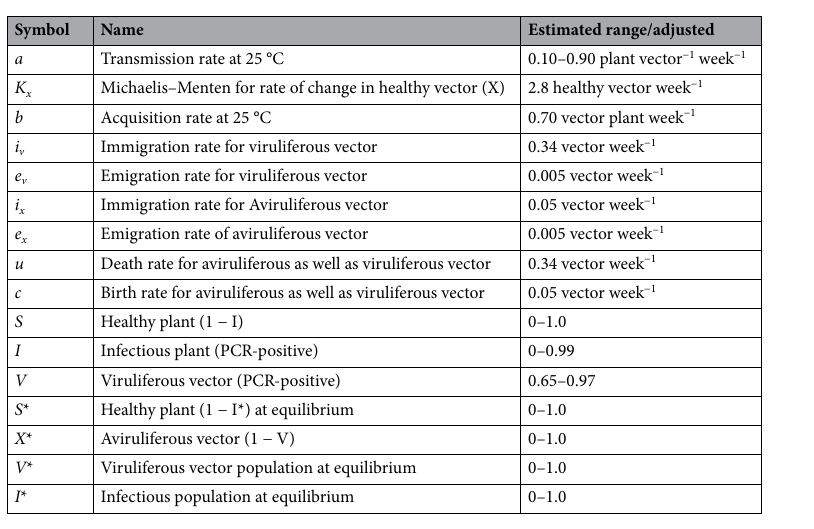
tions. Transmission parameters estimated under semi-controlled conditions were tuned to match population of healthy host and viruliferous vector. Values of model parameters and variables tuned or adjusted for leaf curl epidemic analysis are given in Table 2. Population of healthy host ( S ) was predicted fitting host dynamics model ( dS/dt = − aVS ) and found to correspond with the observed proportion of healthy chili plants in the field (Fig. 2). Transmission or inoculation rate ( a = 0.12) was approximately close to simulate healthy host population in the field as indicated by low RMSE. Acquisition rate ( b = 0.70) estimated under semi-controlled conditions and used to simulate virulifeorus vector population fitting vector population dynamics model (dV/dt = b[1 − V]